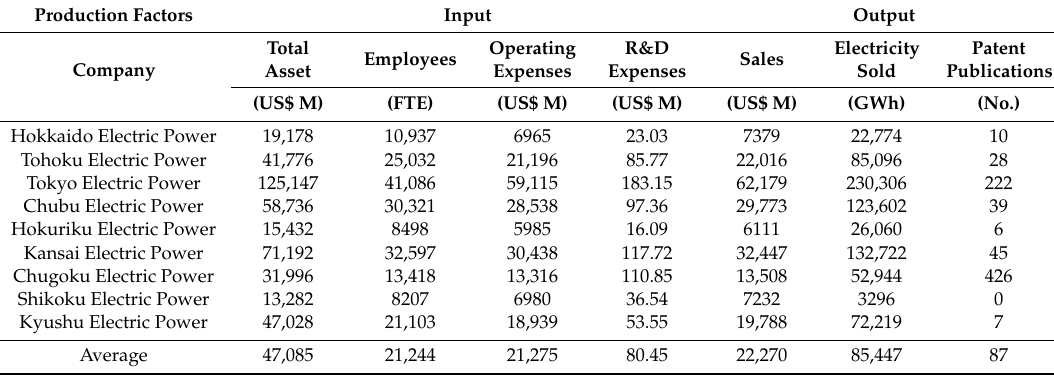
Table 2. Data of Japanese Power Companies in 2018: An Illustrative Example.